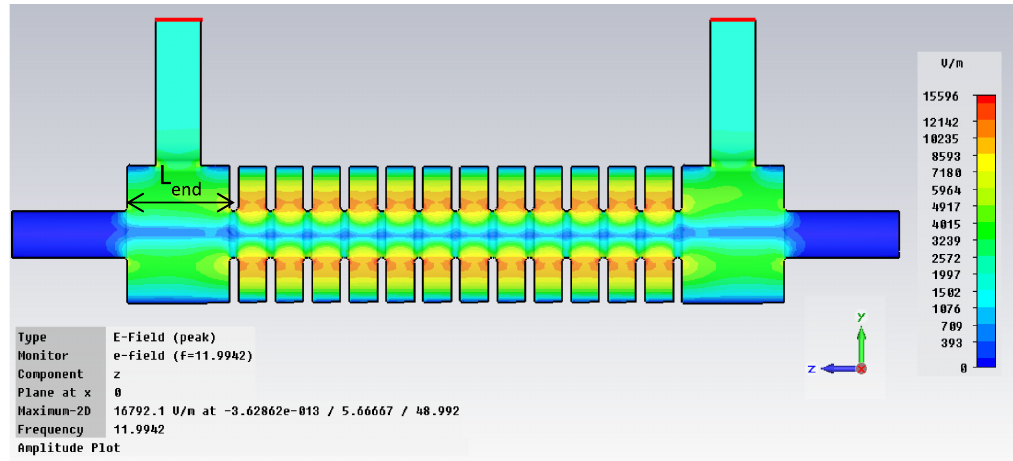
FIG. 14. Single-feed standard coupler with extra-long end cells.